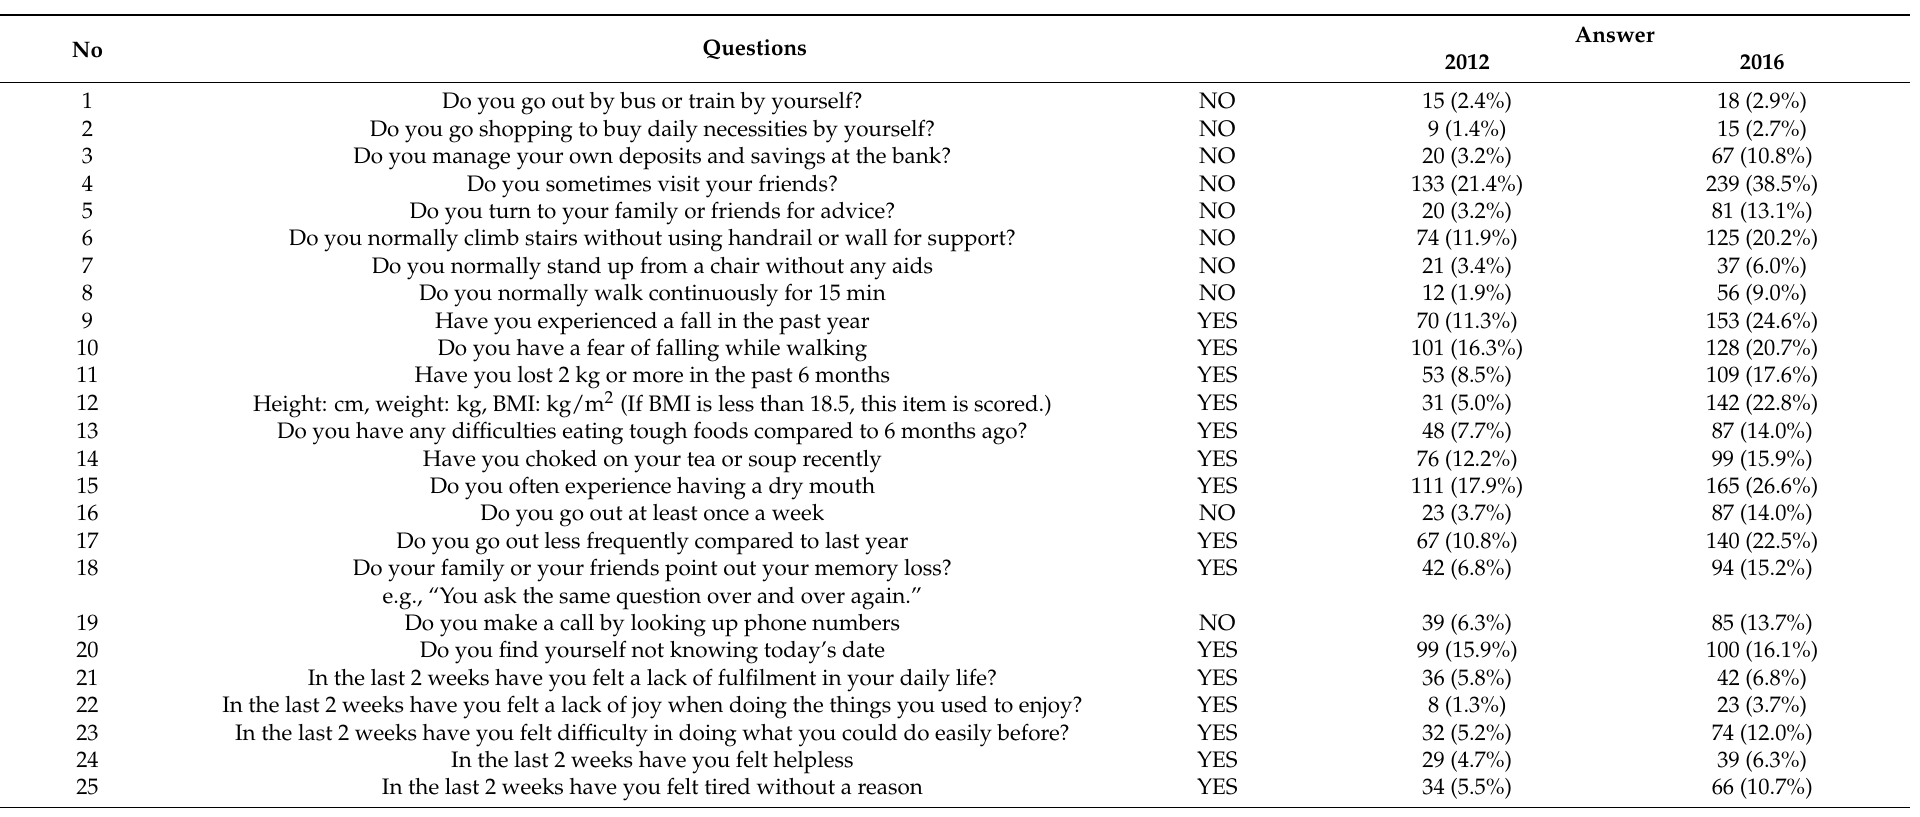
Table A1. 2012 and 2016 KCL applicable